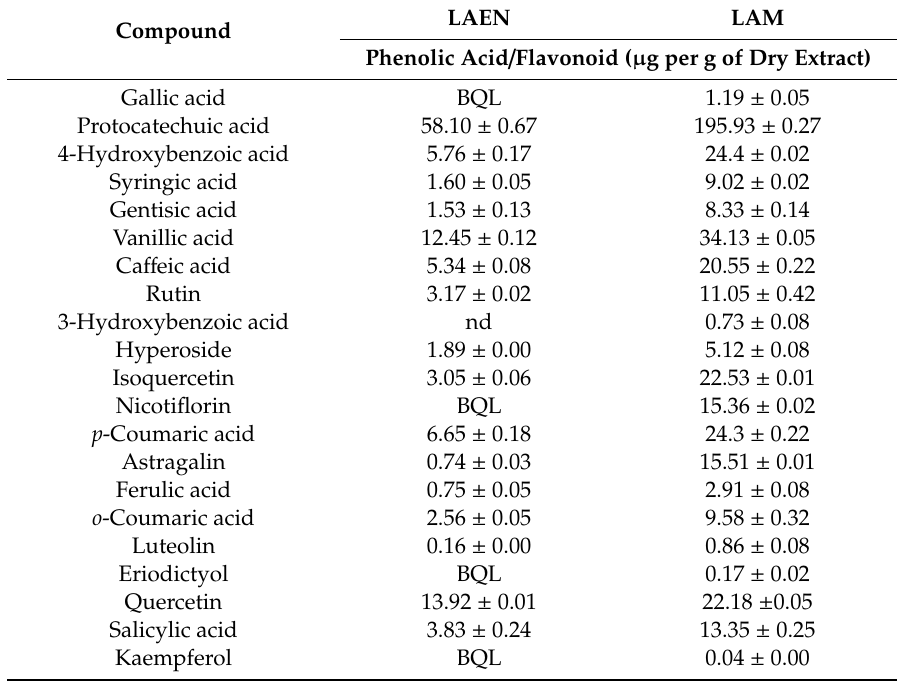
Table 4. Content of phenolic acids and flavonoid aglycones and glycosides in the etheric (LAEN) and methanolic (LAM) extracts from L. krap ffi i fruits. Values are presented in means ± SEM, n = 3. nd—not detected; BQL—peak detected, concentration lower than the LOQ but higher than the